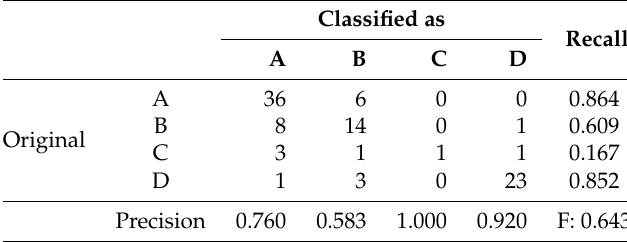
Table 12. Confusion matrix of label visibility classification in offline experiment.